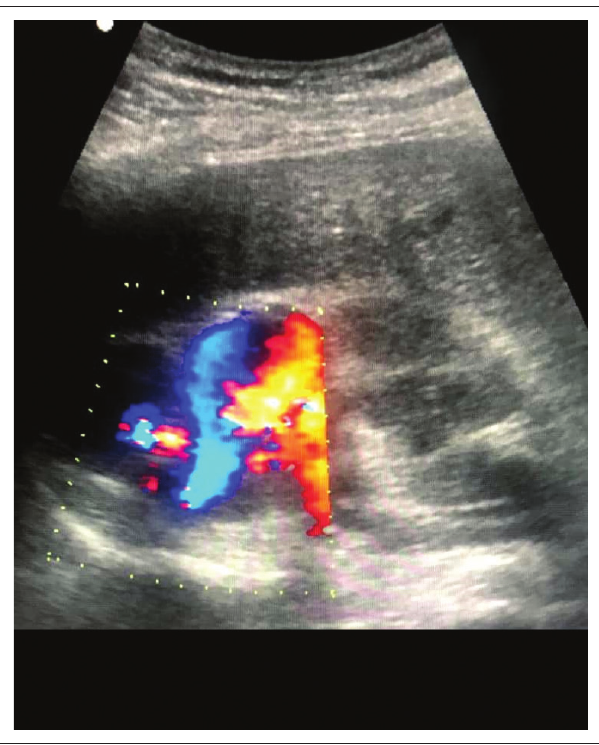
FIG URE 1: Ultrasound and Doppler study outlining a large, high-output arteriovenous communication in the upper pole of the right